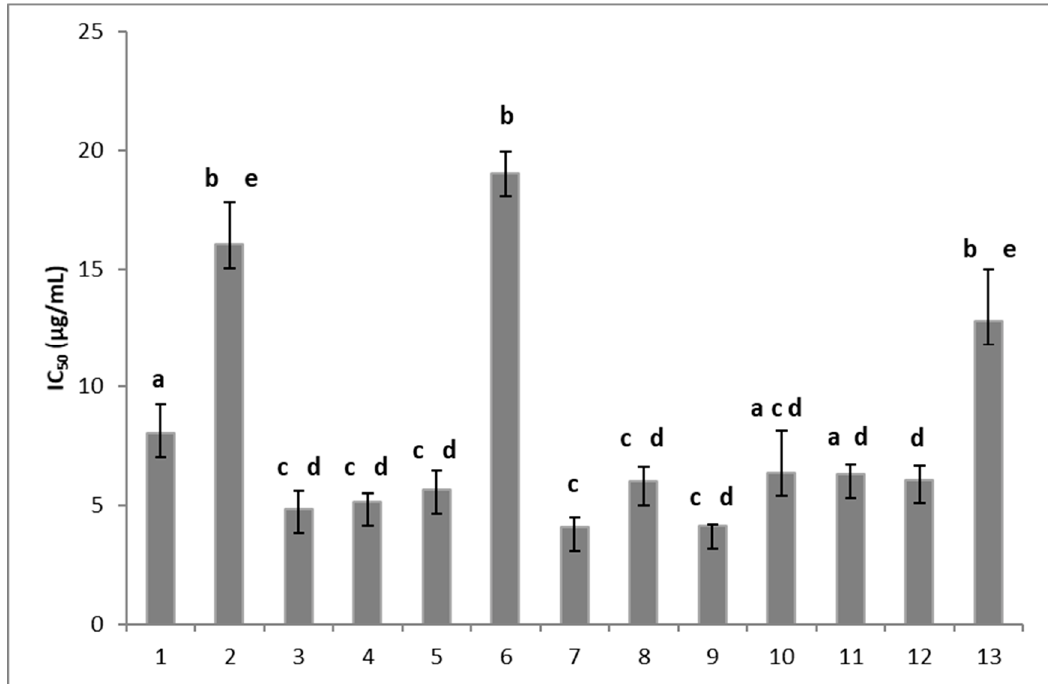
Figure 2. Effect of the 8,8-dimethyl-3-[( R -phenyl)amino]-1,4,5(8 H )-naphthalentrione derivatives on the mycelial growth of Botrytis cinerea. The number on the x-axis indicates the tested compound. Each column represents the mean ± standard deviation of three independent experiments. Different letters indicate that the means are significantly different at p < 0.05.